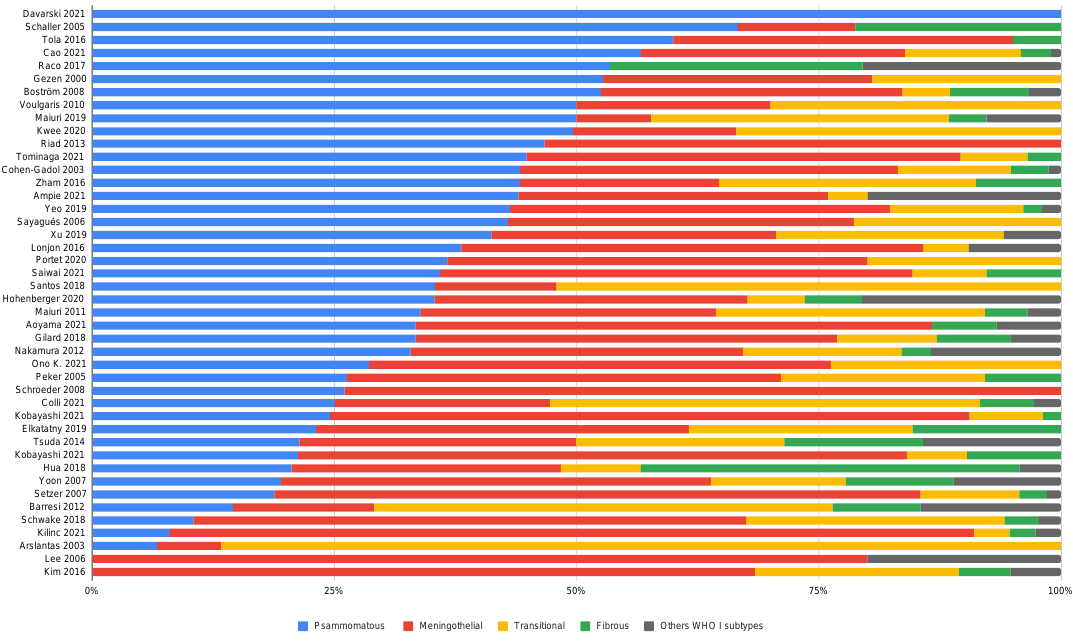
Figure 2. Distribution of the four most common meningioma subtypes as reported by the studies.